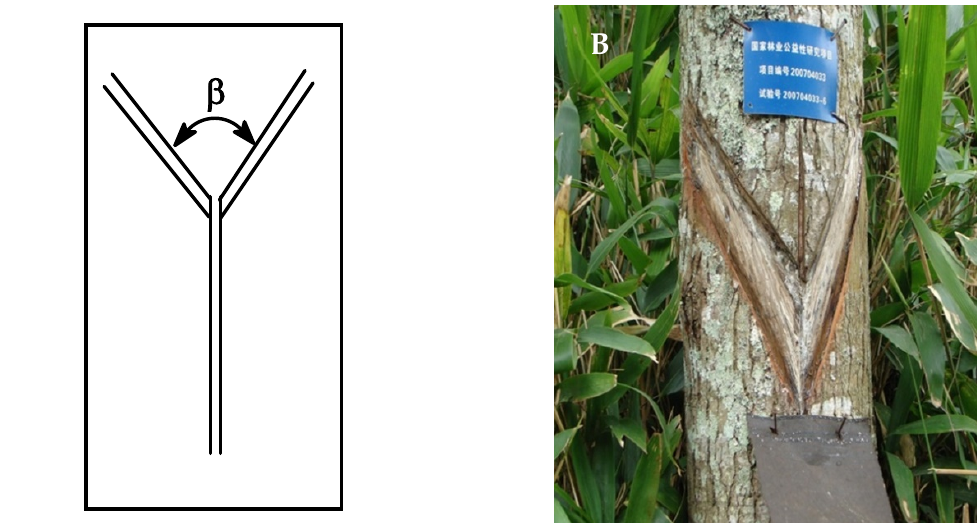
Figure 3. Illustration of the V-shaped downward tapping method. A : Schematic diagram, B : Photograph of appropriately tapped L. formosana .